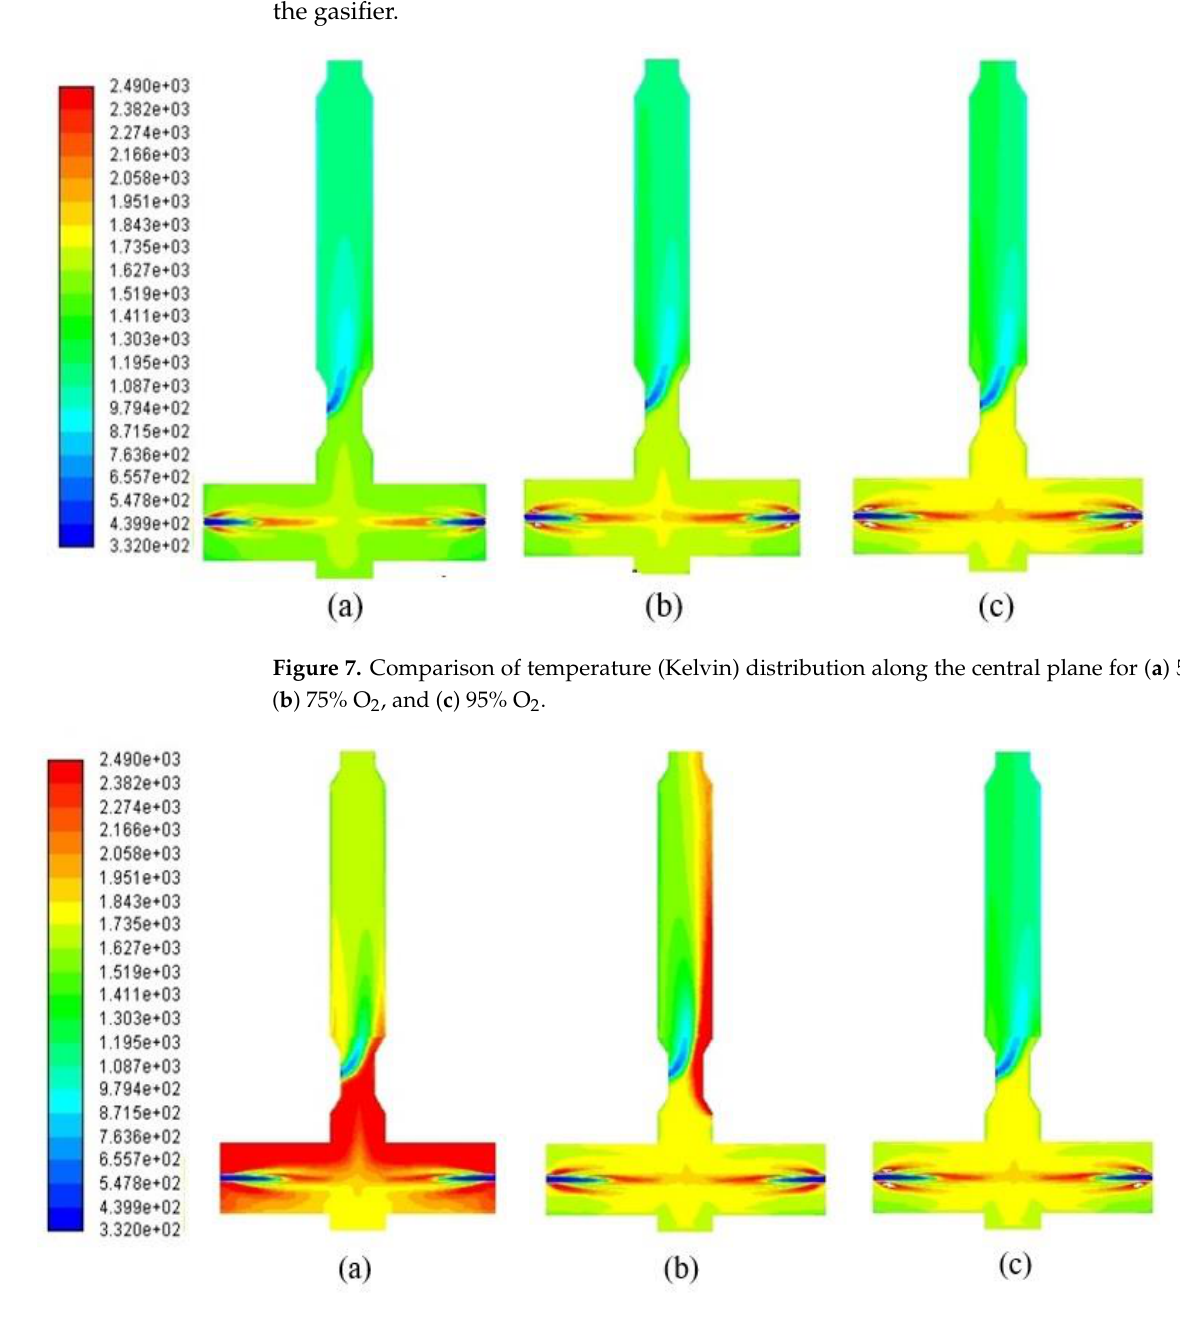
Figure 8. Comparison of temperature (Kelvin) distribution between ( a ) solar energy (10%) in stage 1, ( b ) solar energy (10%) in stage 2, and ( c ) without solar patch.